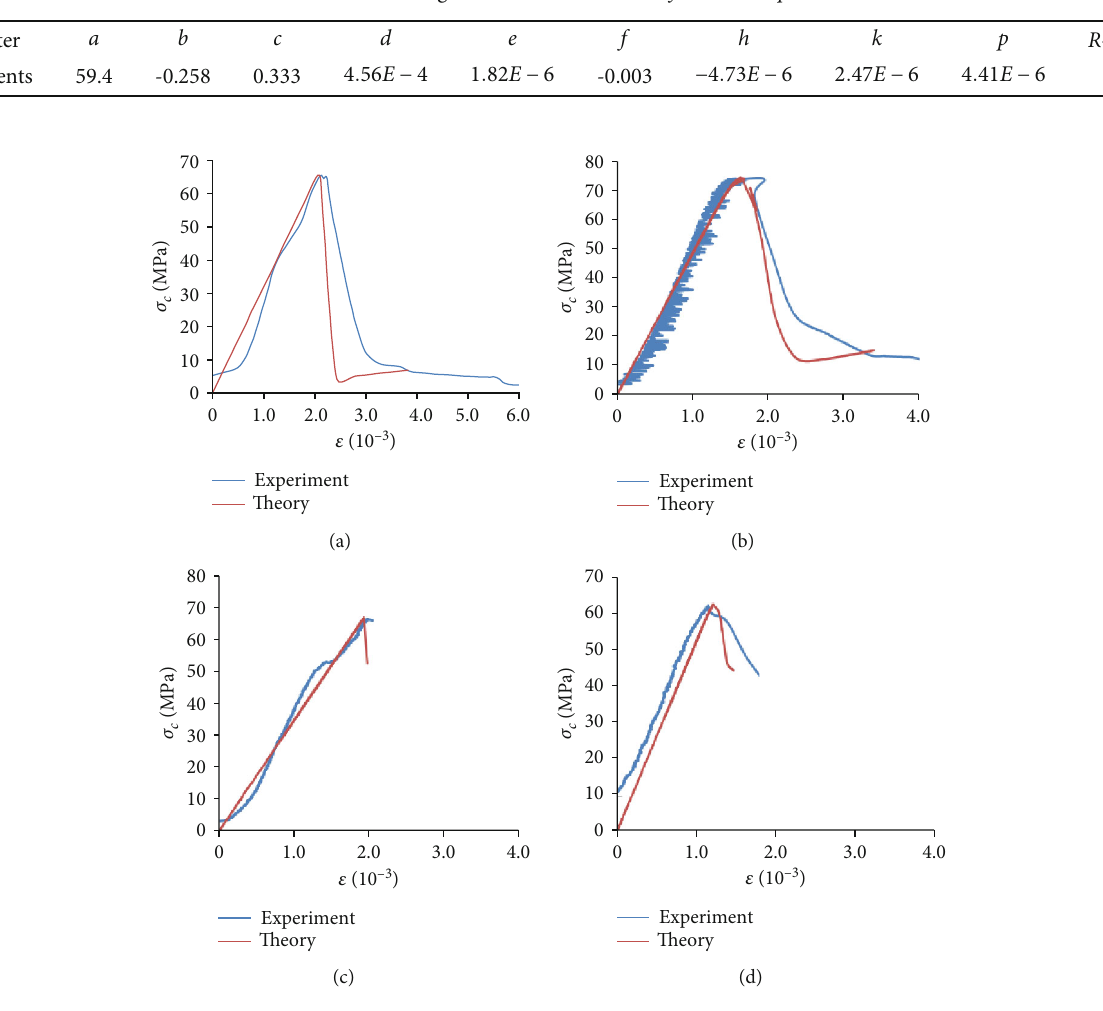
Figure 3: Experimental and theoretical curves of stress-strain of concrete with composite admixture under 30 (a), 110 (b), 190 (c), and 270 (d) days of corrosion after 30 freeze-thaw cycles.